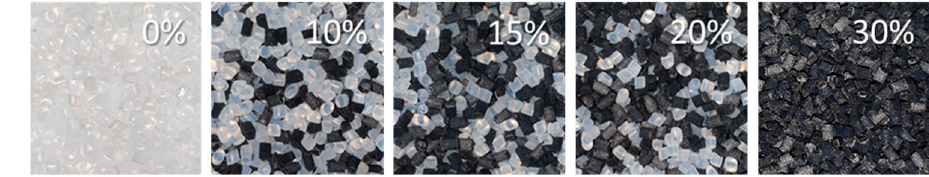
Figure 1. Mixed pellets to obtain different fiber mass fraction.